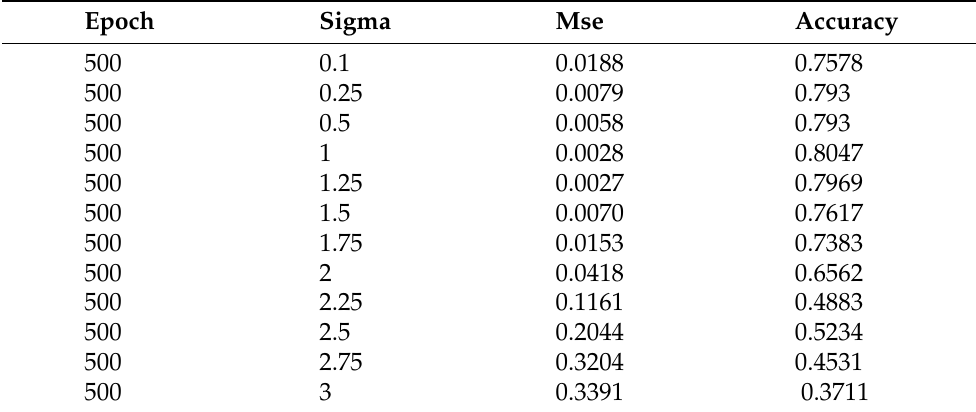
Table 12. Calculated and analyzed MSE for the different sigma